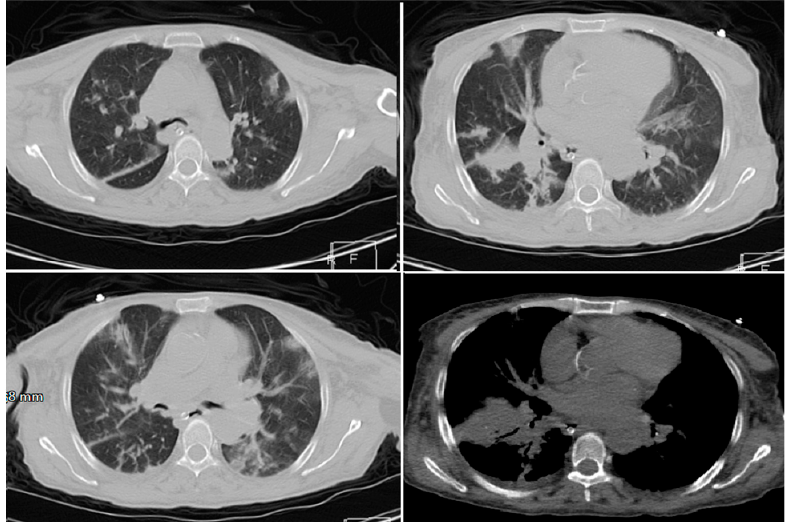
Figure 11. Chest MDCT scan, lung window, axial plane: Bilateral multilobar multifocal ground glass and alveolar opacities with random peribronchovascular and peripheral distribution are seen. Right side mild pleural effusion is seen.